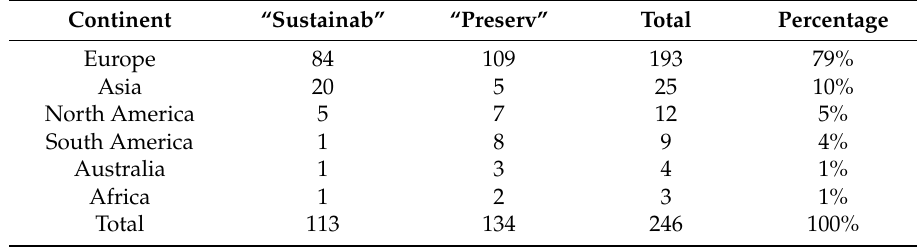
Table 1. Distribution of the publications by continent within the two main research communities involved, i.e., the sustainability and conservation specialists.